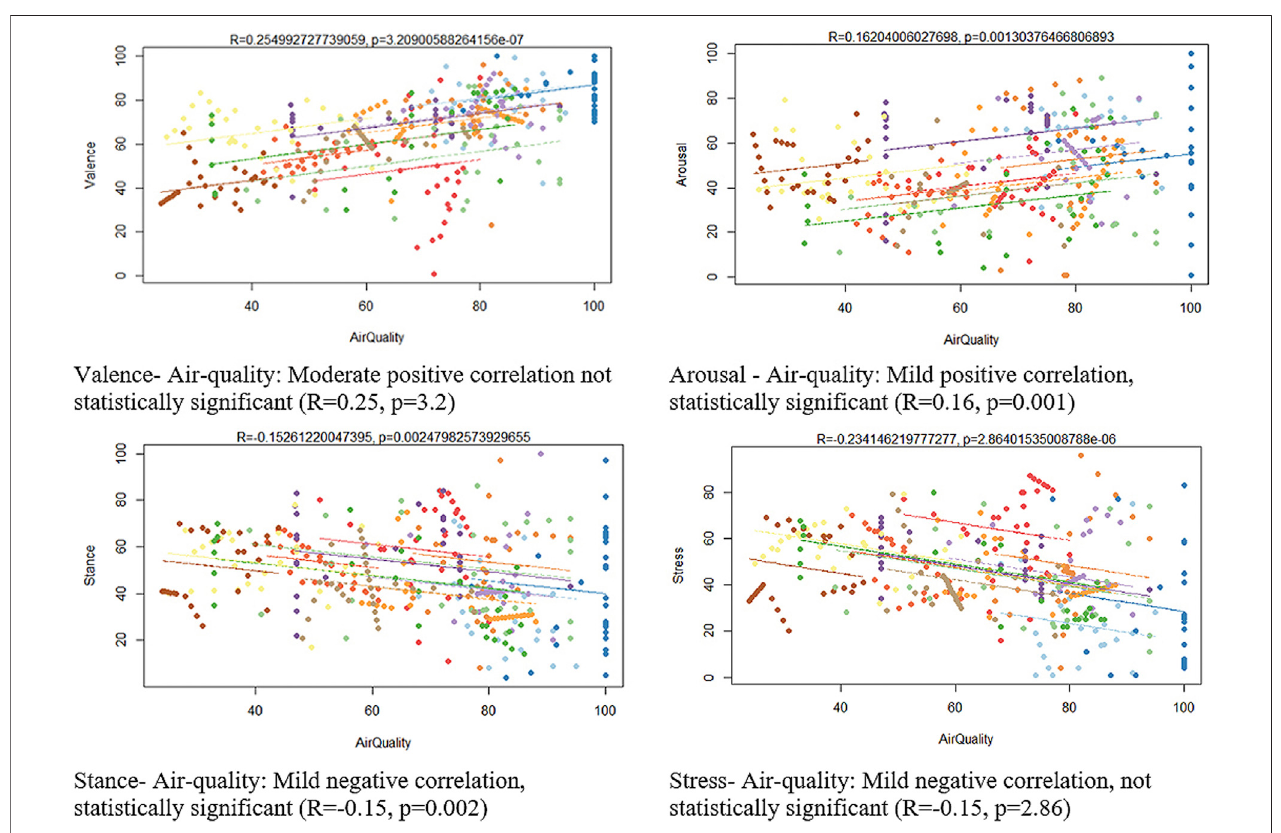
FIGURE 8 | Air quality and dimensions of mood